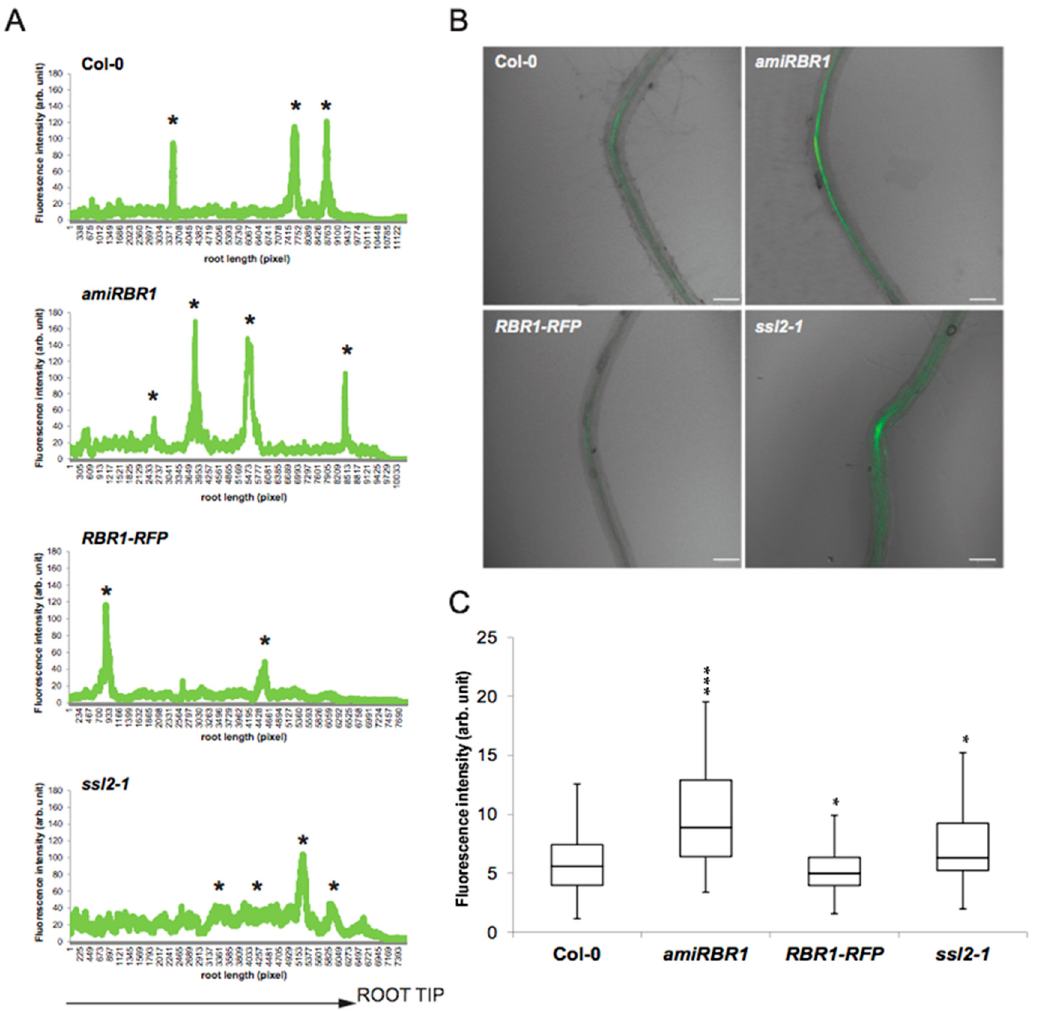
Figure 5. Functional analysis of the effect of RBR1 and PKL proteins on LBD16 promoter. ( A ) Activity of the pLBD16:GFP reporter construct in 6 DAG roots of Col-0, amiRBR1 , RBR1-RFP and ssl2-1 lines. The graph shows GFP fluorescence intensity (arbitrary units) along the stele versus root length (in pixels). Asterisk (*) represents lateral root primordia/lateral roots. ( B ) Result of the root bending test. The confocal images show representative pictures from the bended sites of roots of different lines expressing pLBD16::GFP after 5 h following the 12 h long gravistimuli, and ( C ) the quantified data are summarized in box plots. The intensity of GFP fluorescence (arbitrary units) was measured in at least 31 roots per line; significance was evaluated by two-sided t -test at p < 0.05 (*) or p < 0.001 (***). n Col-0 = 39, n amiRBR1 = 41, n RBR1-RFP = 31, n ssl2-1 = 35. The scale bar on ( B ) = 100 µ